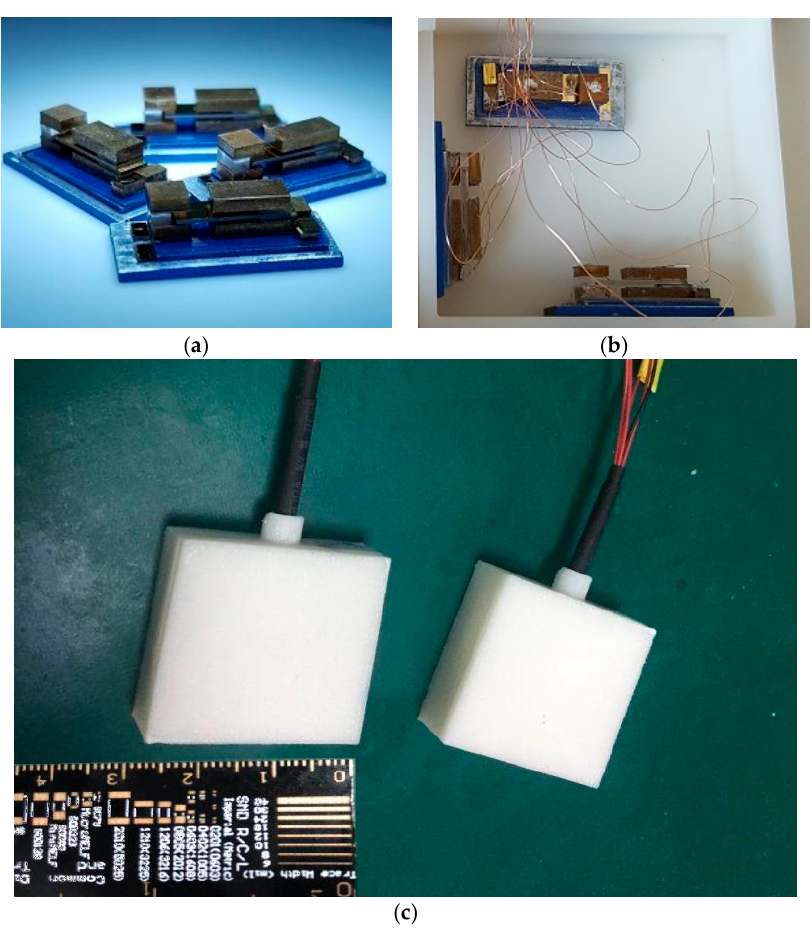
Figure 7. The packaging of sensor prototype. ( a ) The sensor units ( b ) The sensor units are placed in three directions ( c ) The packaging and the size of sensor prototype.